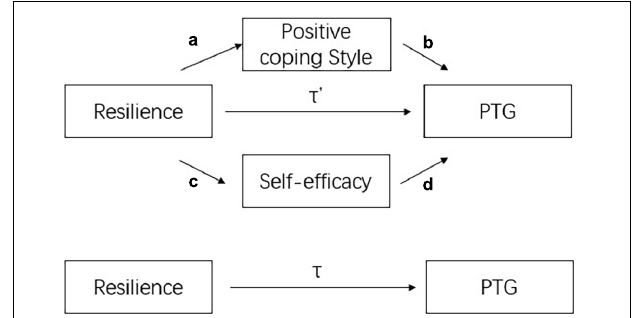
FIGURE 1 | The conceptual framework of mediation model. τ is the unstandardized total effect of resilience on PTG; a is the unstandardized regression coefficient of resilience on positive coping style; b represents the unstandardized partial regression coefficient of positive coping style on PTG after controlling for the effect of resilience on PTG; c is the unstandardized regression coefficient of resilience on self-efficacy; d represents the unstandardized partial regression coefficient of self-efficacy on PTG after controlling the effect of resilience on PTG; and τ (cid:48) is the unstandardized direct effect of resilience on PTG.